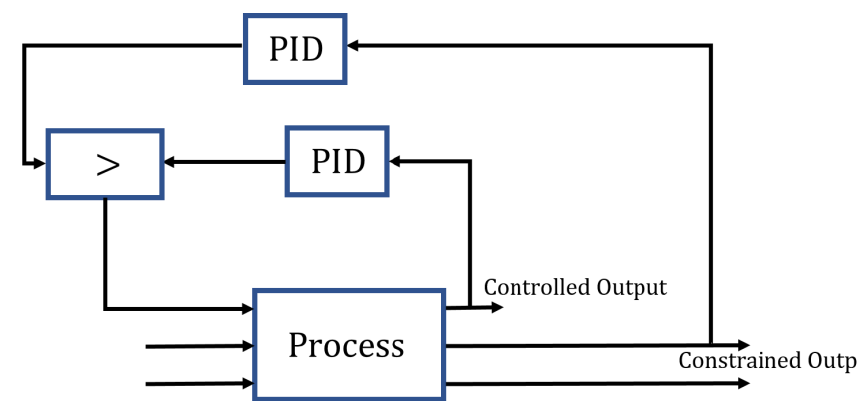
Figure 2. Override control architecture with high-pass selector logic [37].